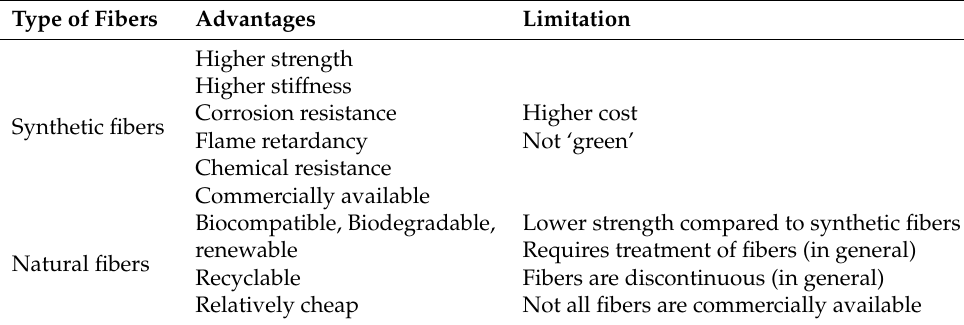
Table 3. The advantages and limitations for synthetic fibers and natural fibers as reinforced material for FDM printed polymer